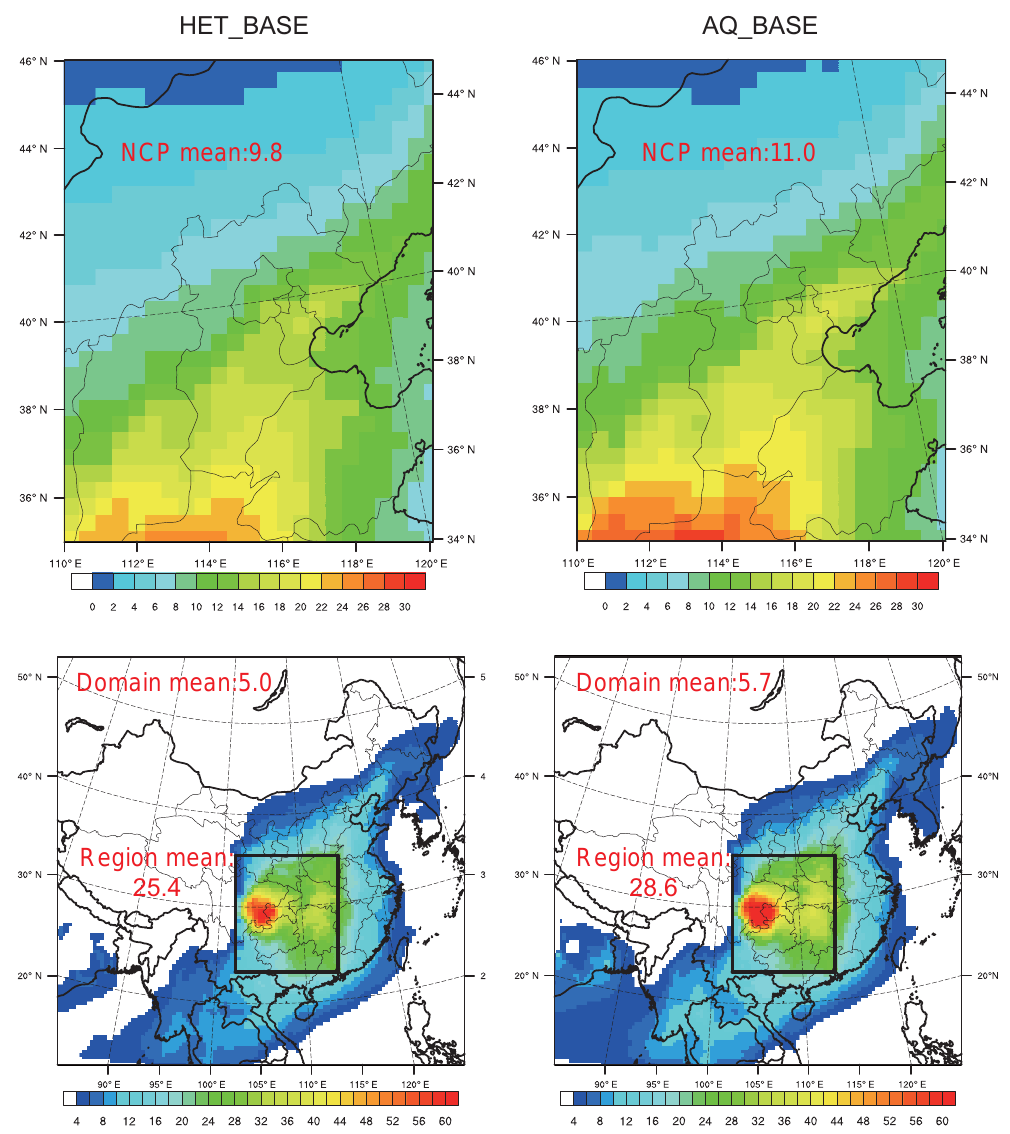
Figure 10. Spatial distribution of mean sulfate (in PM 2 . 5 ) from HET_BASE and AQ_BASE (units: µgm − 3 ) for the period of 15–31 October